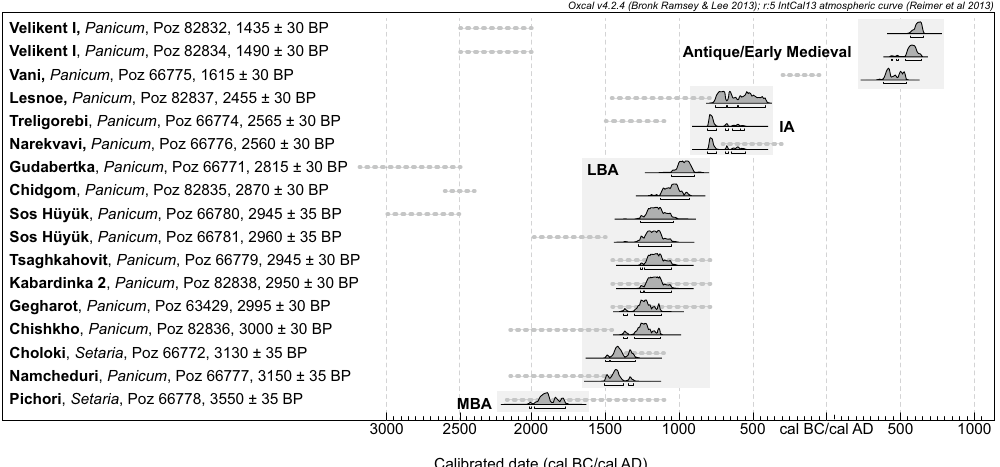
Figure 2. Calibrated radiocarbon dates made directly on millet grains. MBA: Middle Bronze Age; LBA: Late Bronze Age; IA: Iron Age. Chronological landmarks from Sagona 2016 27 . The grey dotted lines indicate the expected time period of the levels from which the millet samples are taken, according to archaeological data. Dated are calibrated using OxCal 4.2.4 software using IntCal13 atmospheric curve (references and details in SI appendix fig. S1 and tab. S2; dataset